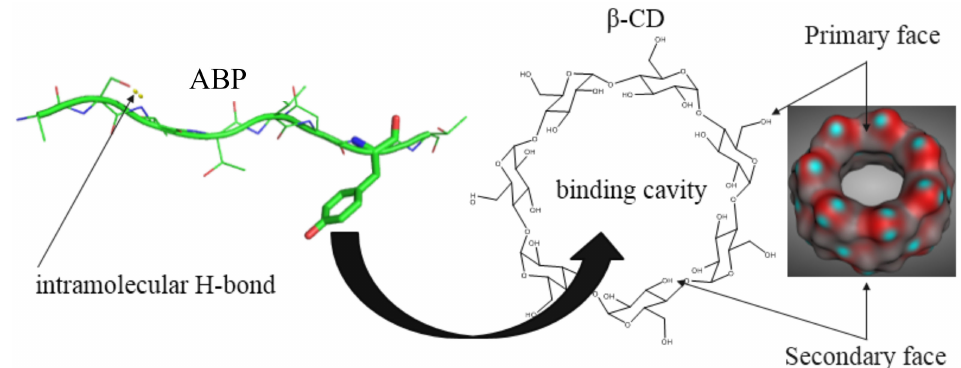
Figure 1. Hypothetical ABP/ β -CD (anti-bacterial peptide/ β -cyclodextrin) complexation/formulation process via the molecular docking of peptide lipophilic side chains into the hydrophobic β -CD binding